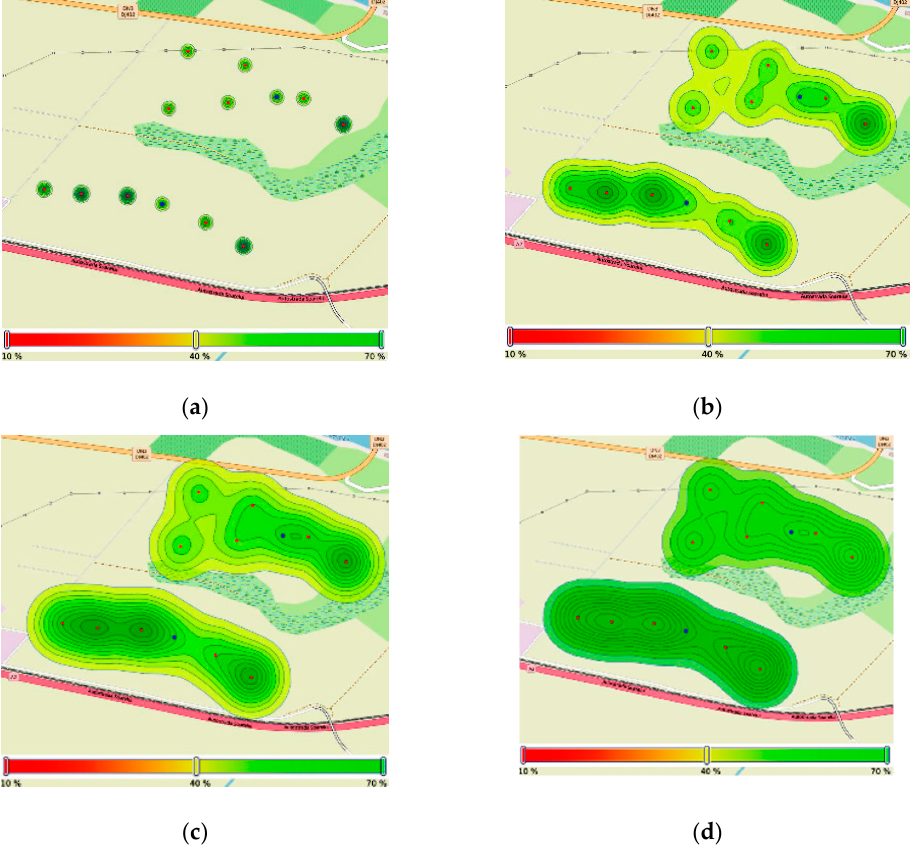
Figure 16. Soil moisture map in Zone 2, before and after consensus: ( a ) location of soil moisture sensors; ( b ) soil moisture map after 10 iterations; ( c ) soil moisture map after 20 iterations; and ( d ) soil moisture map after 30 iterations.